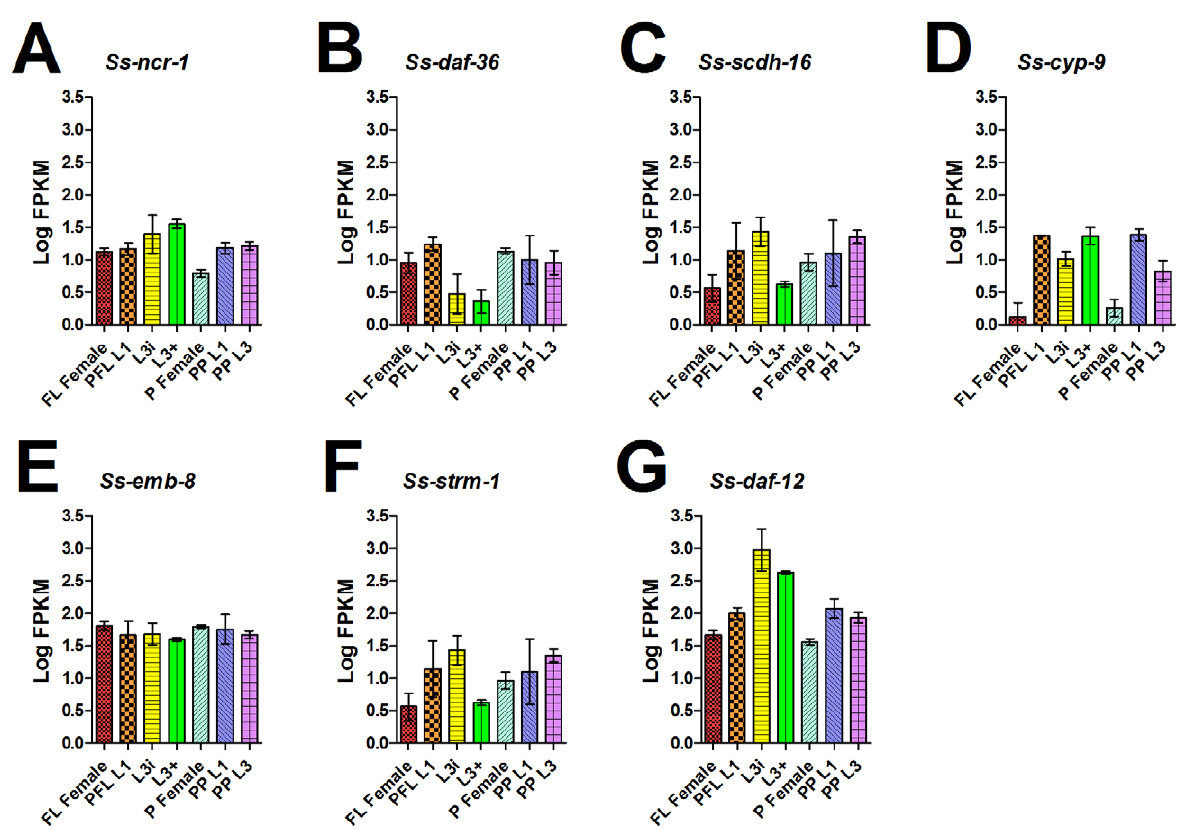
Figure 7. Temporal regulation of S.stercoralis DAF-12 and genes putatively involved in dafachronic acid synthesis. Transcript abundances were determined for the coding region of: (A) Ss-ncr-1 , a gene encoding a homolog of the intracellular cholesterol transporters Ce -NCR-1 and Ce -NCR-2; (B) Ss-daf-36 , a gene encoding a homolog of the Rieske-like oxygenase Ce -DAF-36; (C) Ss-scdh-16 , a gene encoding a short-chain dehydrogenase homolog most similar to Ce -DHS-16; (D) Ss-cyp-9 , a gene encoding a cytochrome P450 homolog most similar to Ce -DAF-9; (E) Ss-emb- 8 , a gene encoding a homolog of the cytochrome P450 reductase Ce -EMB-8; (F) Ss-strm-1 , a gene encoding a homolog of the methyltransferase Ce - STRM-1; and (G) Ss-daf-12 , the homolog of the nuclear hormone receptor Ce -DAF-12. Transcript abundances were quantified in seven developmental stages: free-living females (FL Female), post-free-living first-stage larvae (PFL L1), infectious third-stage larvae (L3i), in vivo activated third-stage larvae (L3 + ), parasitic females (P Female), post-parasitic first-stage larvae (PP L1), and post-parasitic third-stage larvae (PP L3). Transcript abundances were calculated as fragments per kilobase of coding exon per million mapped reads (FPKM) and log transformed. Error bars represent 95% confidence intervals. The y-axes were scaled from 0 to 3.5 to aid comparison between